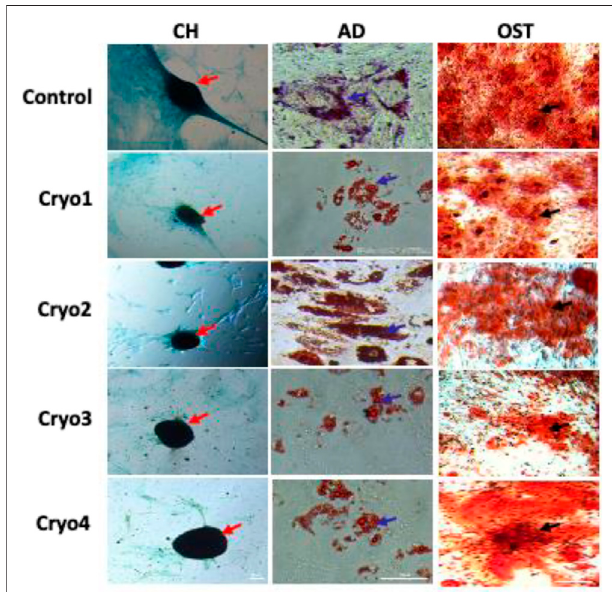
FIGURE6| Representativeimages showing thepotentialtodifferentiate into chondrocytes (CH), adipocytes (AD), and osteoblasts (OST) of the non- frozen (Control) and cryoprocessed AT-MSCs. Chondrogenic differentiation was con fi rmed by Alcian blue staining, blue color indicates glycosaminoglycans in cartilage (red arrows); adipogenic differentiation was evaluated by Oil Red, the differentiated culture demonstrates lipid vacuoles, which typical for mature adipocytes (blue arrows); osteogenic differentiation was assessed by Alizarin Red staining of deposition of matrix calci fi cation (black